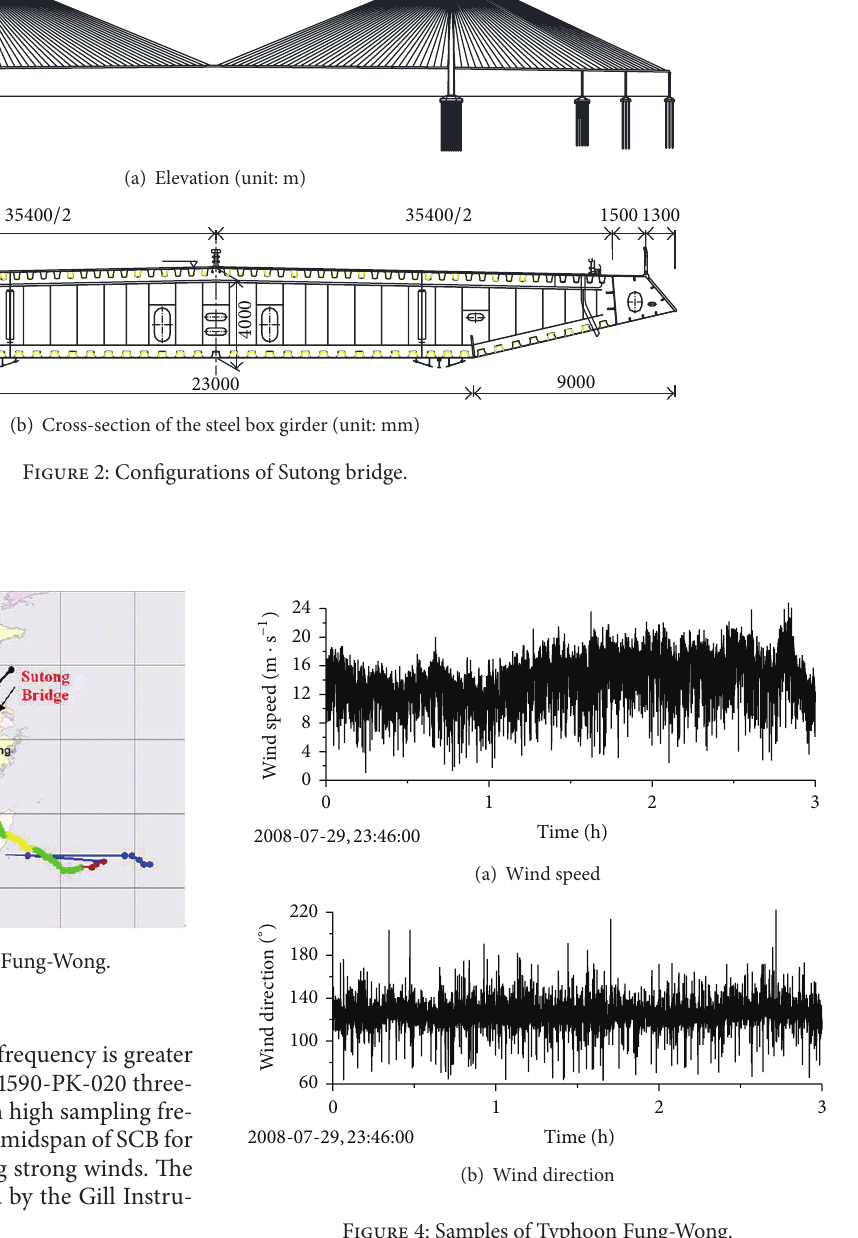
Figure 4: Samples of Typhoon